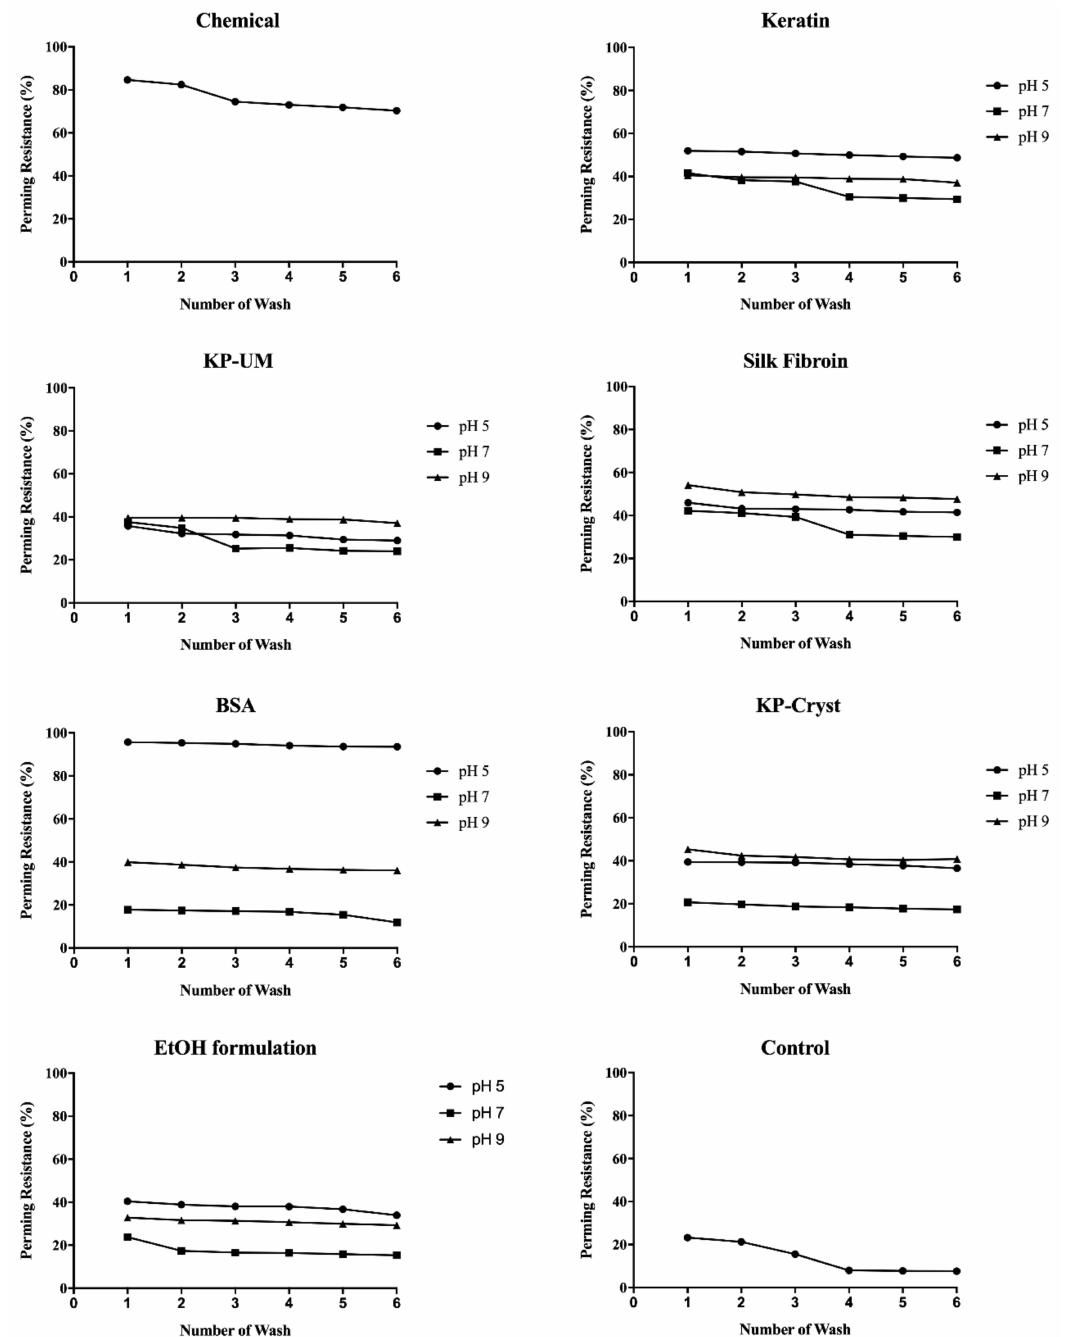
Figure 5. Hair perming resistance across six wash cycles with commercial shampoo. The resistance values were obtained by comparing the perming efficiencies after a certain wash cycle with the perming efficiencies before any washing